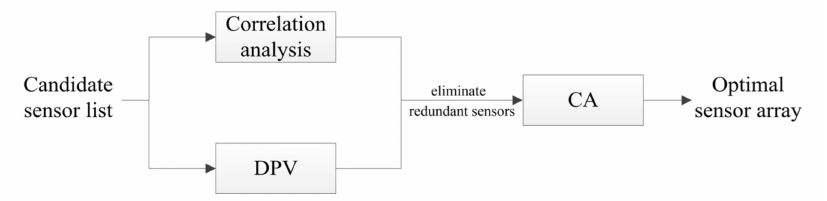
Figure 6. The flow chart of the sensor array optimization